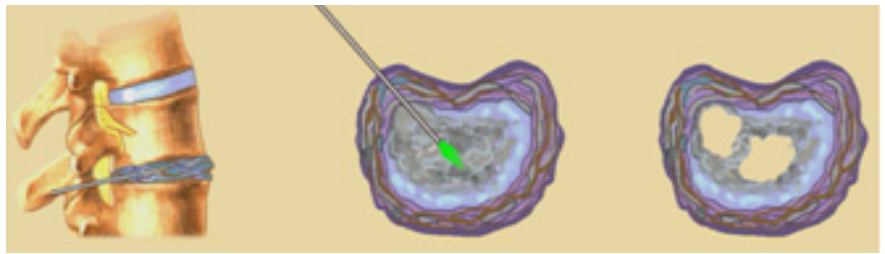
Figure 5. Scheme of LRD technology.